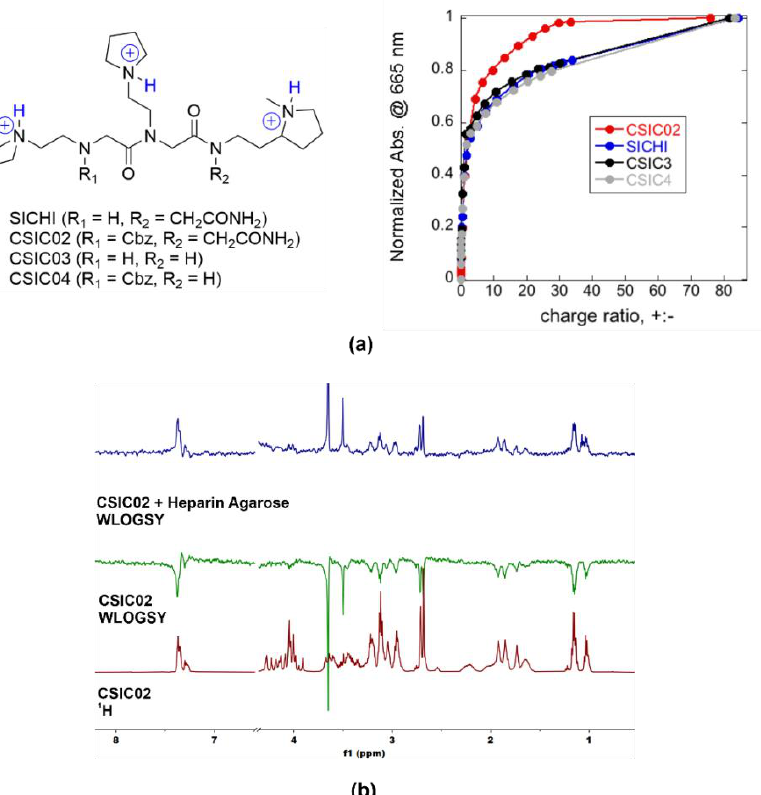
Figure 6. ( a ) Chemical structures of triprotonated SICHI and CSIC02–04, as the main species in aqueous medium at neutral pH, and relative increase in MB absorbance at 665 nm versus charge ratio after the addition of the peptoids to the preformed MB/heparin complex (4.71 µM Hep repeating units + 9.83 µM MB in 5 mM Tris buffer at pH = 7.5). ( b ) 1D 1 H WaterLOGSY NMR experiments showing that CSIC02 binds to heparin agarose resin (used as a GAG mimetic).